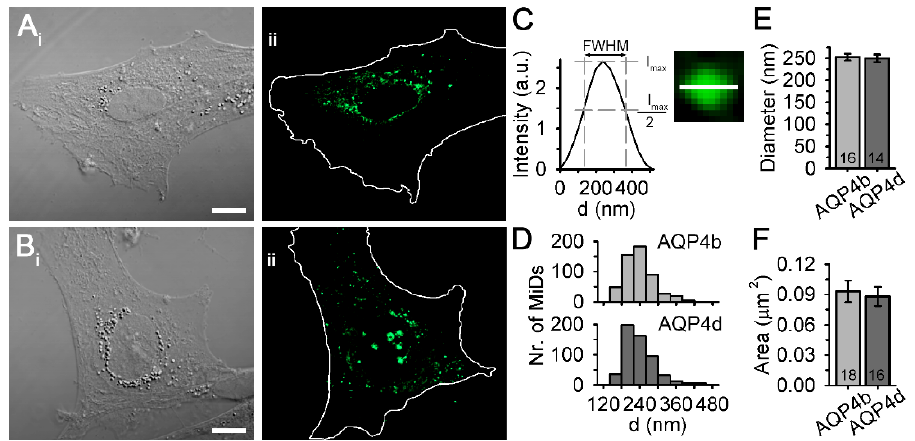
Figure 1. Microdomains (MiDs) of aquaporin (AQP)4b and AQP4d in astrocytes. ( A,B ) DIC and fluorescence micrographs of primary rat astrocytes overexpressing GFP-tagged AQP4b ( A ii ) and AQP4d ( B ii ). White lines outline cell shapes. Scale bars: A i (for A i , A ii ) and B i (for B i , B ii ), 10 µ m. ( C ) Diameters of MiDs were determined by measuring the full-width at half-maximum (FWHM) of the fluorescence intensity profile along the equatorial line horizontally and vertically (structured illumination microscopy micrograph of AQP4d MiD shows only the horizontal direction; the length of the line is 400 nm). ( D ) Diameter frequency distributions for AQP4b and AQP4d MiDs. The diameters of AQP4b MiDs were in the range of 139–570 nm and the diameters of AQP4d MiDs were in the range of 139–530 nm. ( E ) The average diameter of AQP4b MiDs (252 ± 8 nm) was similar to that of AQP4d MiDs (249 ± 9 nm, p = 0.72, Mann–Whitney test). ( F ) The average area of AQP4b MiDs (0.09 ± 0.01 µ m 2 ) was similar to the average area of AQP4d MiDs (0.09 ± 0.01 µ m 2 , p = 0.67, Mann–Whitney test). Data represent means ± standard error of the mean from five independent experiments (animals) for AQP4b ( n = 531 MiDs) and AQP4d ( n = 548 MiDs) overexpressing astrocytes. The numbers in the bars represent the number of cells